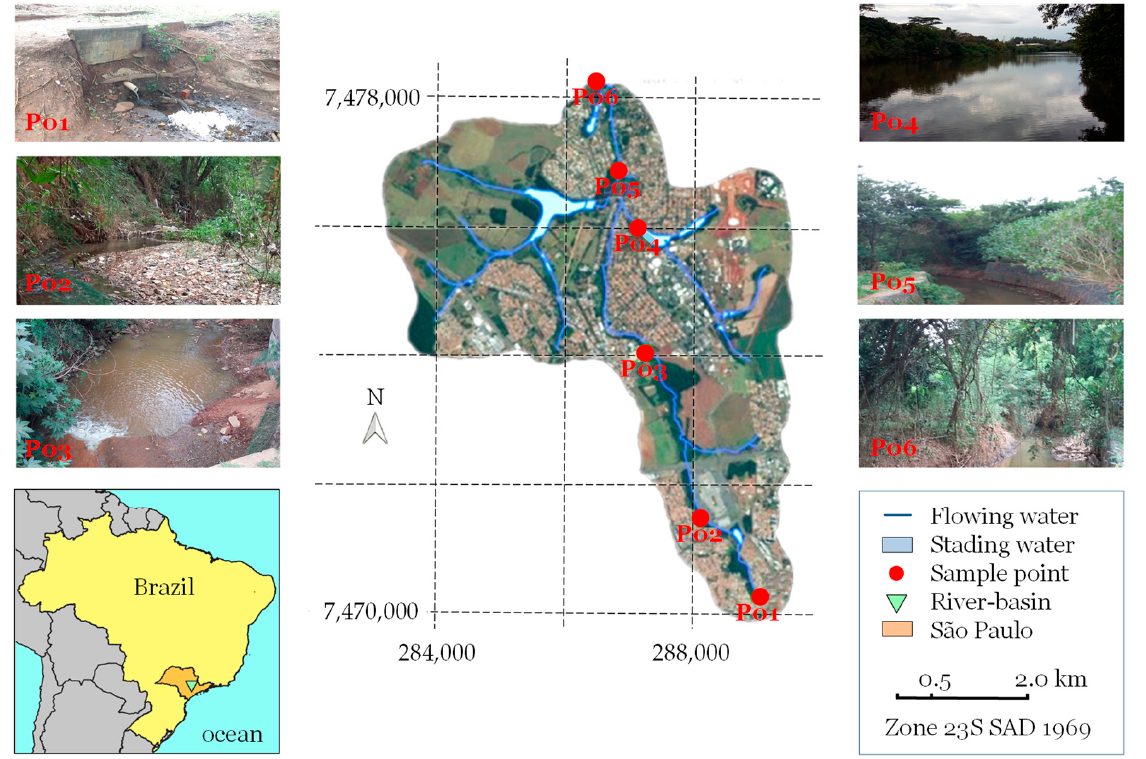
Figure 1. Sampling points in the study area.